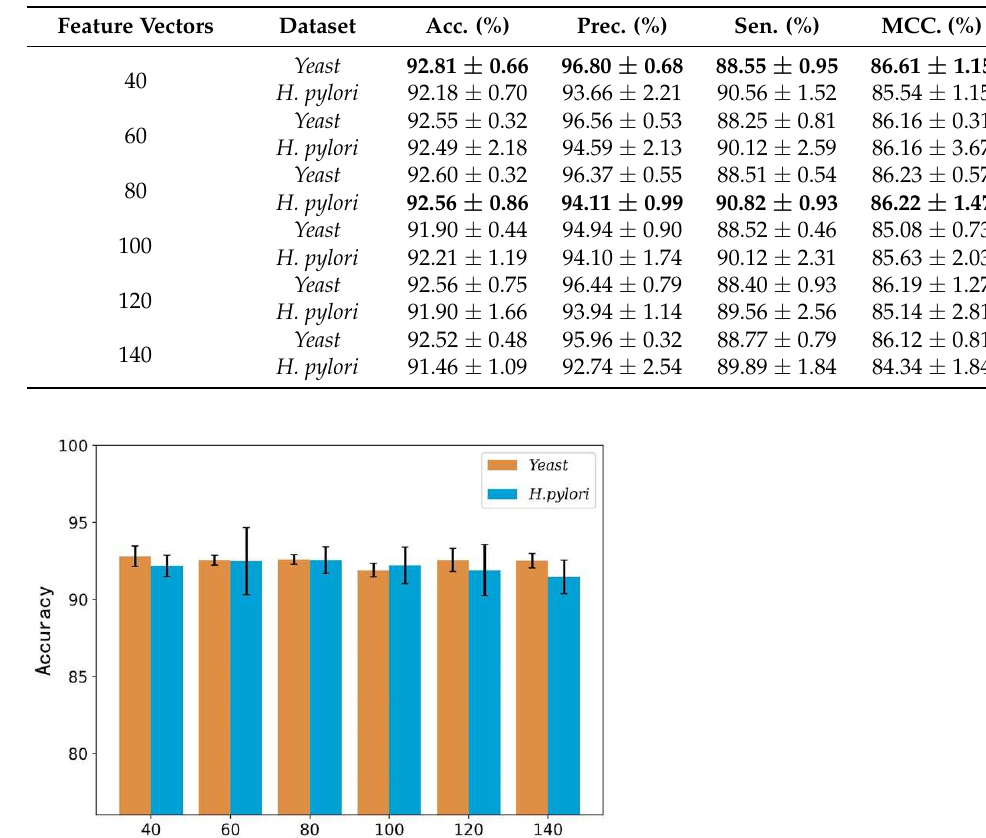
Table 1. The results of different feature vectors on the Yeast and H. pylori datasets.